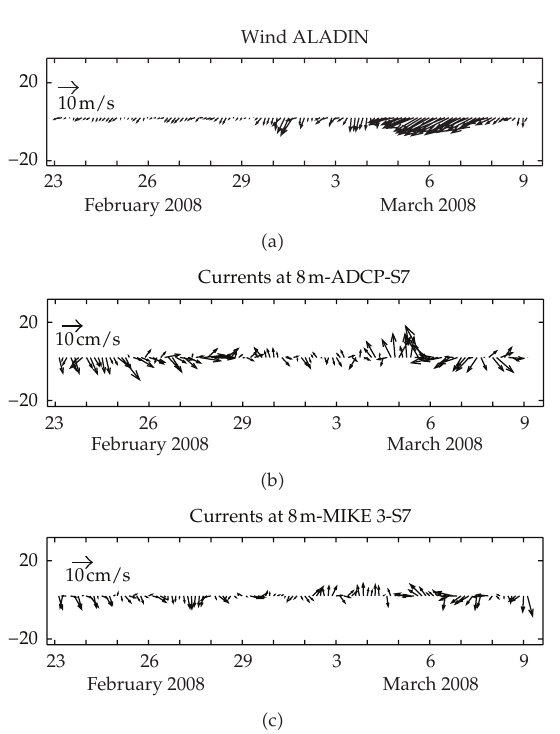
Figure 8: As in Figure 5 but for the ADCP station